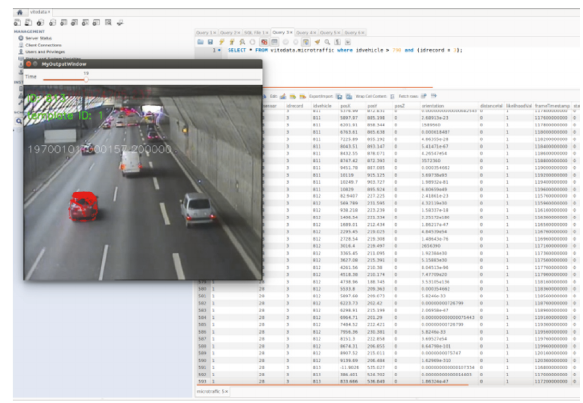
Figure 4: Manual position estimation tool GUI. A specific point cloud is moved on the street surface to best fit a vehicle position. The chosen position is then written into a database for further